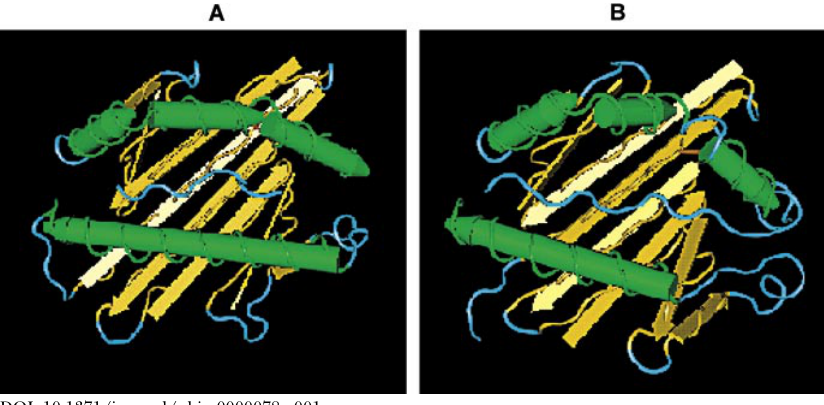
Figure 1. MHC Class I and MHC Class II Bind to Specific TCRs MHC class I and MHC class II bind to specific TCRs on the surface of the MHC molecule that is facing you. The peptide is presented by the MHC to the TCR like a hotdog in a bun; the peptide typically constitutes approximately 15% and the MHC molecule constitutes approximately 85% of the surface that the TCR binds. (A) shows a molecular structure of the human MHC class I, HLA-A2, bound to a tumor antigen, MAGE-4 (Hillig et al. 2001). This structure is distinct from (B), which shows the human MHC class II molecule HLA-DR1 bound to a peptide derived from the Epstein–Barr virus gp42 protein (Mullen et al. 2002) in three ways. (1) The MHC class I peptide is shorter (average of nine amino acids versus 15 amino acids). (2) The ends of the peptide- binding grooves are closed in the MHC class I. (3) Although it is not evident in the structures shown, the binding groove from MHC class II is produced from two distinct molecules; the groove from MHC class I forms from one protein. The class I and II molecules can be found in animals from jawed vertebrates on up the evolutionary tree. (Figure produced with Cn3D version 4 from the National Center for Biotechnology